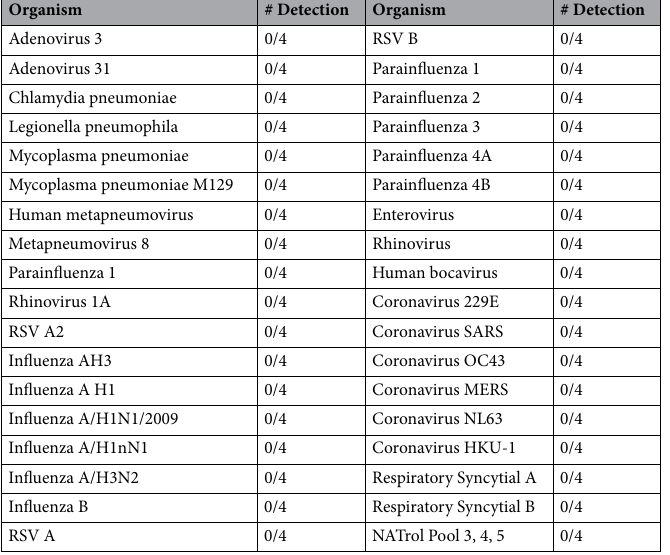
Table 4. Cross-reactivity wet testing of SaliVISION assay with CDC-recommended common respiratory and viral pathogens.